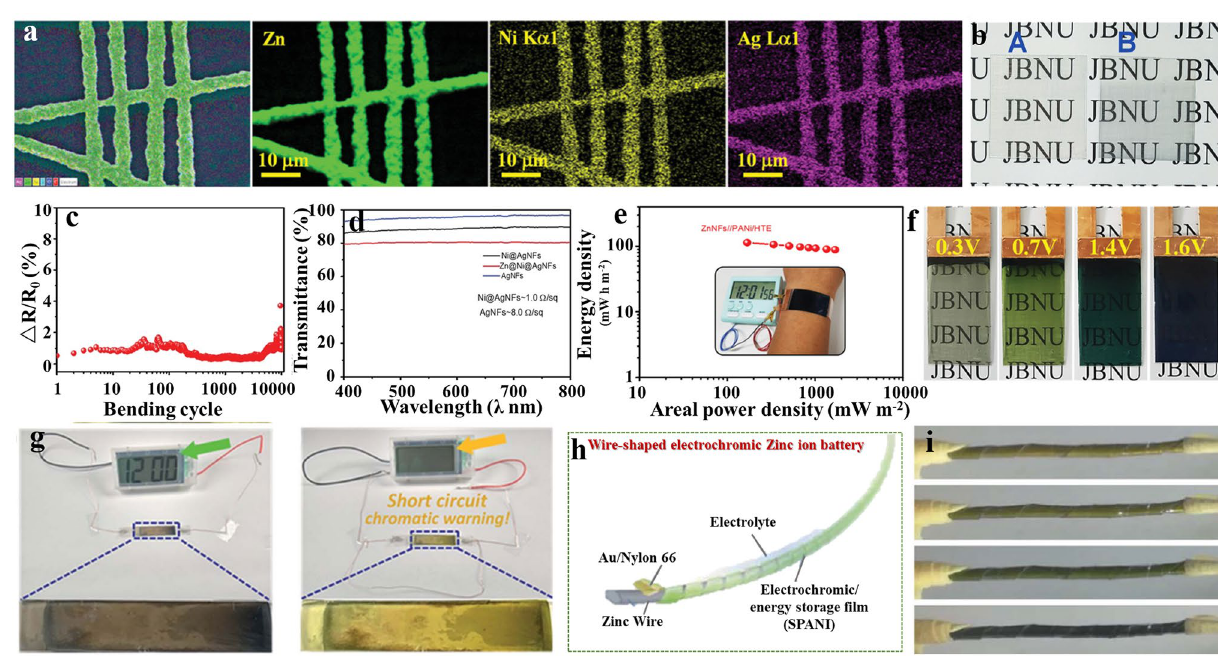
Fig. 10 Advances in wearable MERABs. a EDAX mapping images of the Zn@Ni@AgNFs network. b Digital photographs of the Zn@Ni@ AgNFs electrode. c Bending test of the Zn@Ni@AgNFs electrode. d Optical spectra of the Zn@Ni@AgNFs electrode. e Ragone plot of the MERABs using Zn@Ni@AgNFs electrode. The inset shows the wearable MERAB powering an alarm clock. f Demonstration of color-tuning ability. Reproduced with permission [39]. Copyright 2022, Wiley–VCH. g The prototype with short circuit chromatic waring functions. Repro- duced with permission [37]. Copyright 2018, Royal Society of Chemistry. h Schematic illustration of the structure of the wire-shaped zinc-ion battery. i Digital photos of the coloring and bleached states of the wire-shaped zinc-ion battery. Reproduced with permission [38]. Copyright 2020, Royal Society of Chemistry. (Color figure